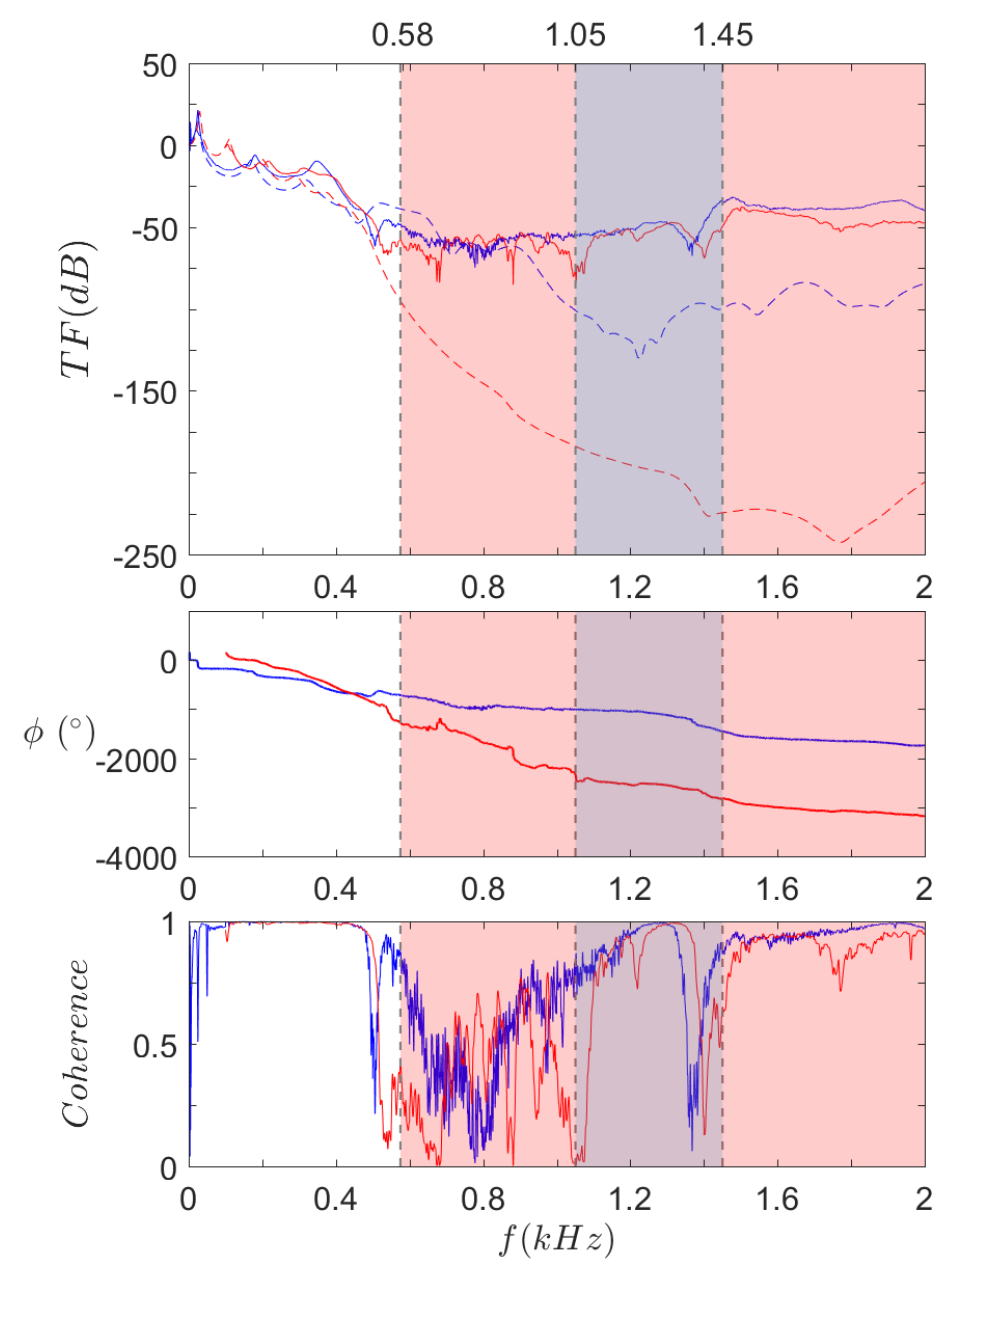
Figure 18. Experimental transfer functions (top), phases (middle), and coherences (bottom) of S 0 and S R , compared to their computed counterpart S 0 and S R . Omnidirectional bandgap ranges under 2 kHz for S 0 and S R , as found in the dispersion